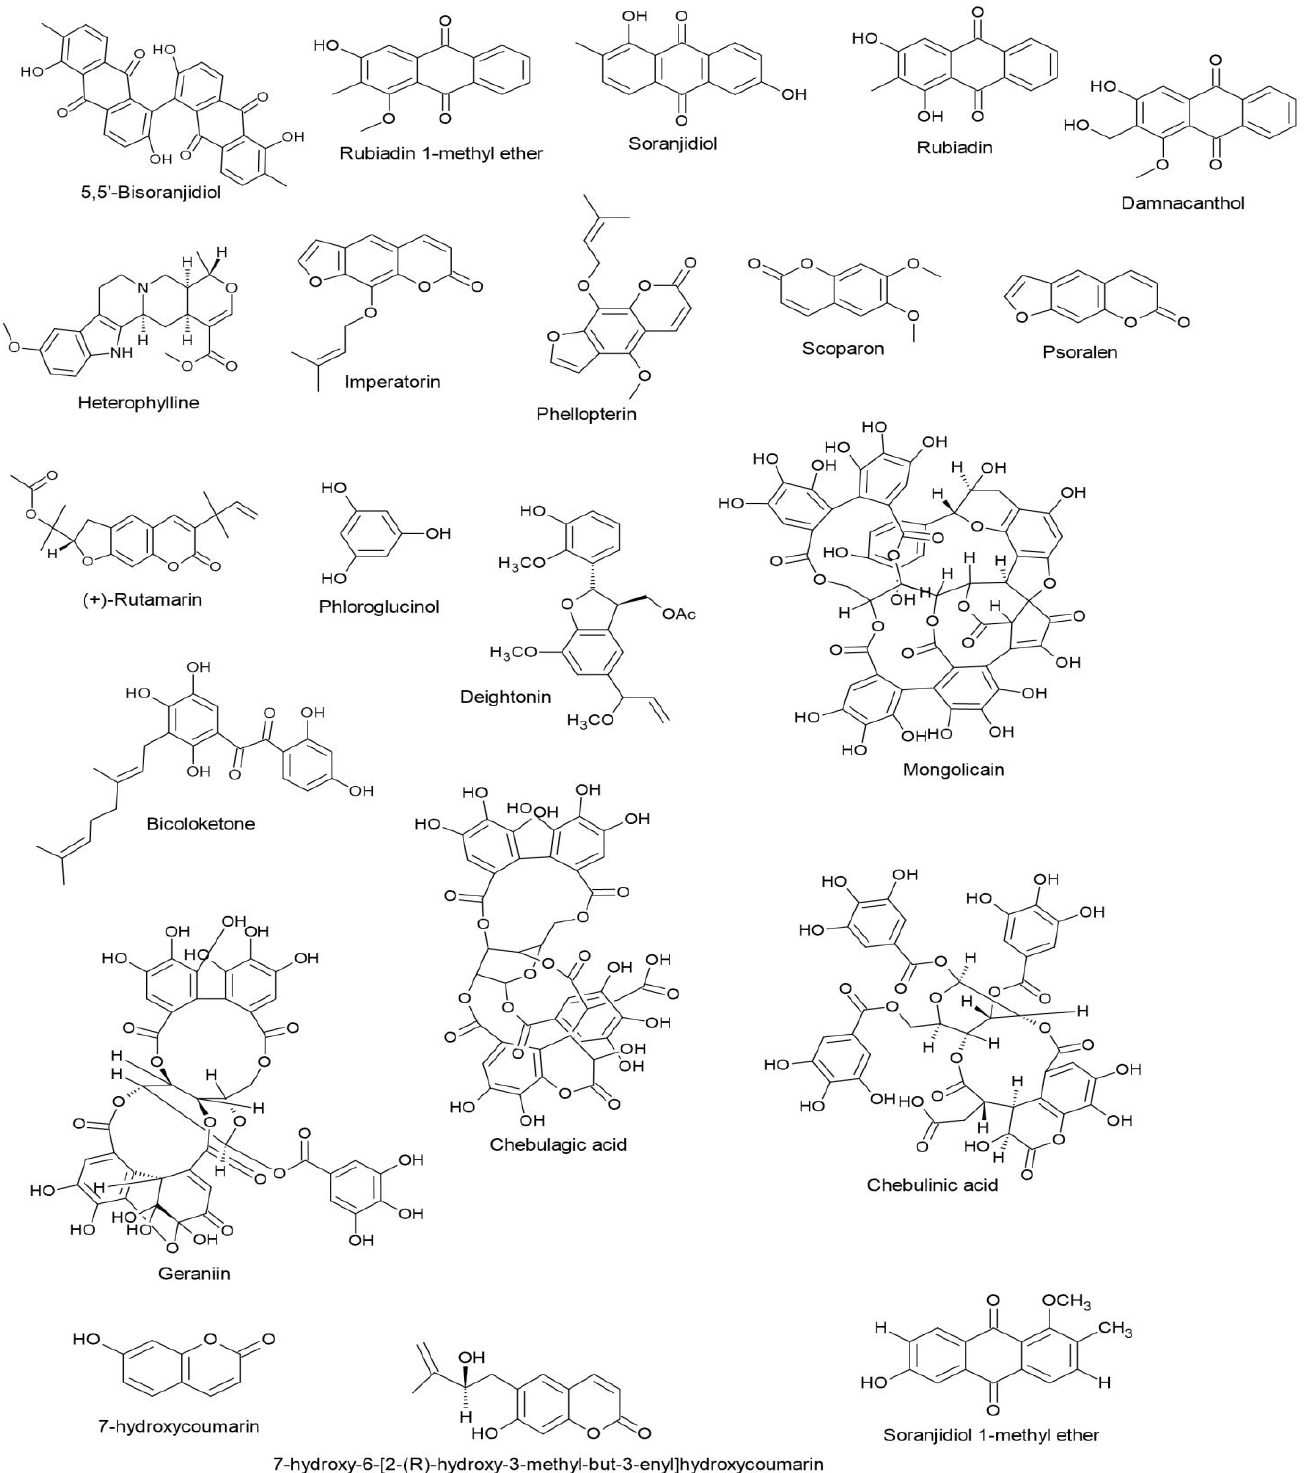
Figure 3. Chemical structures of the reviewed non-flavonoid polyphenols.